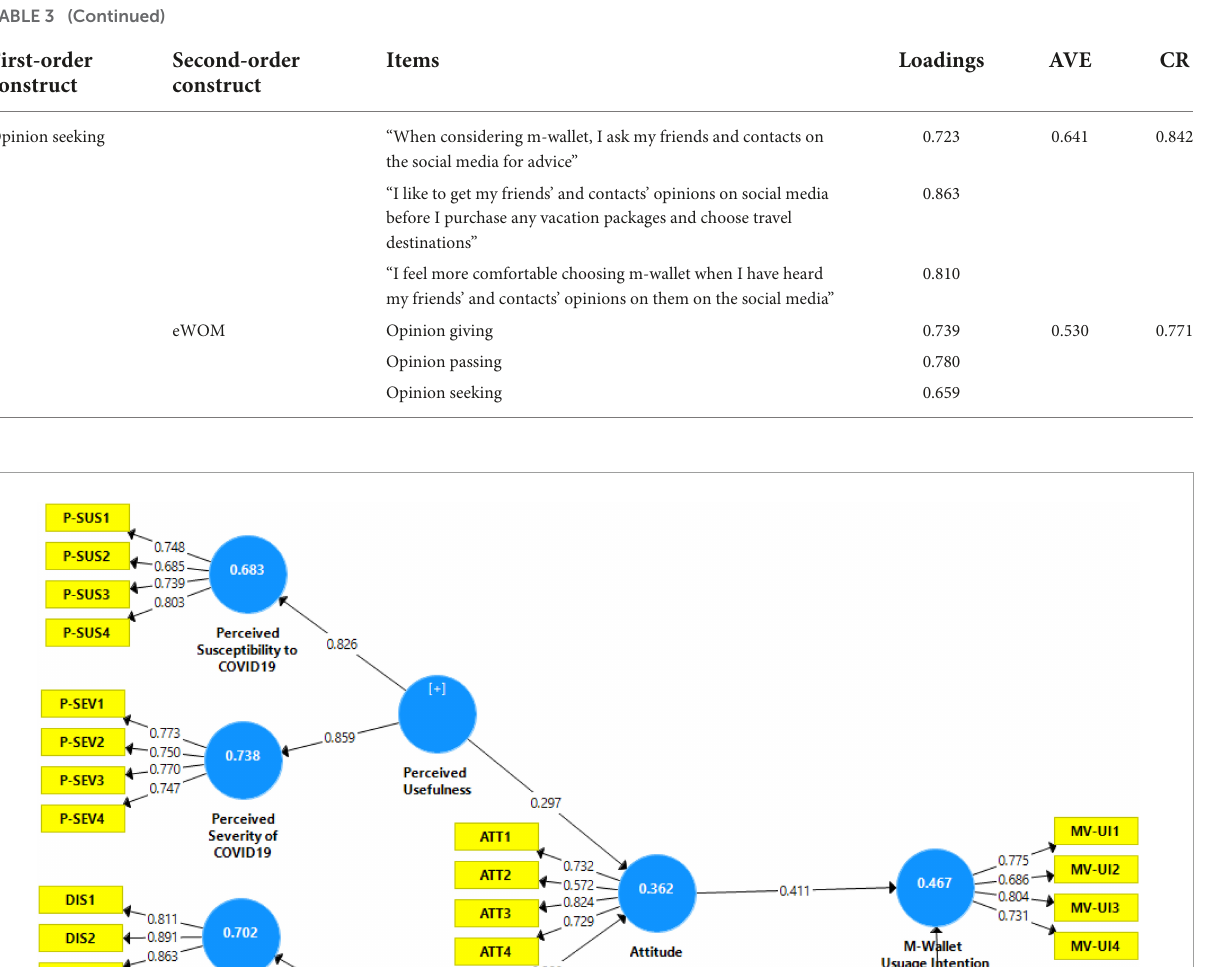
FIGURE3 Measurement model.